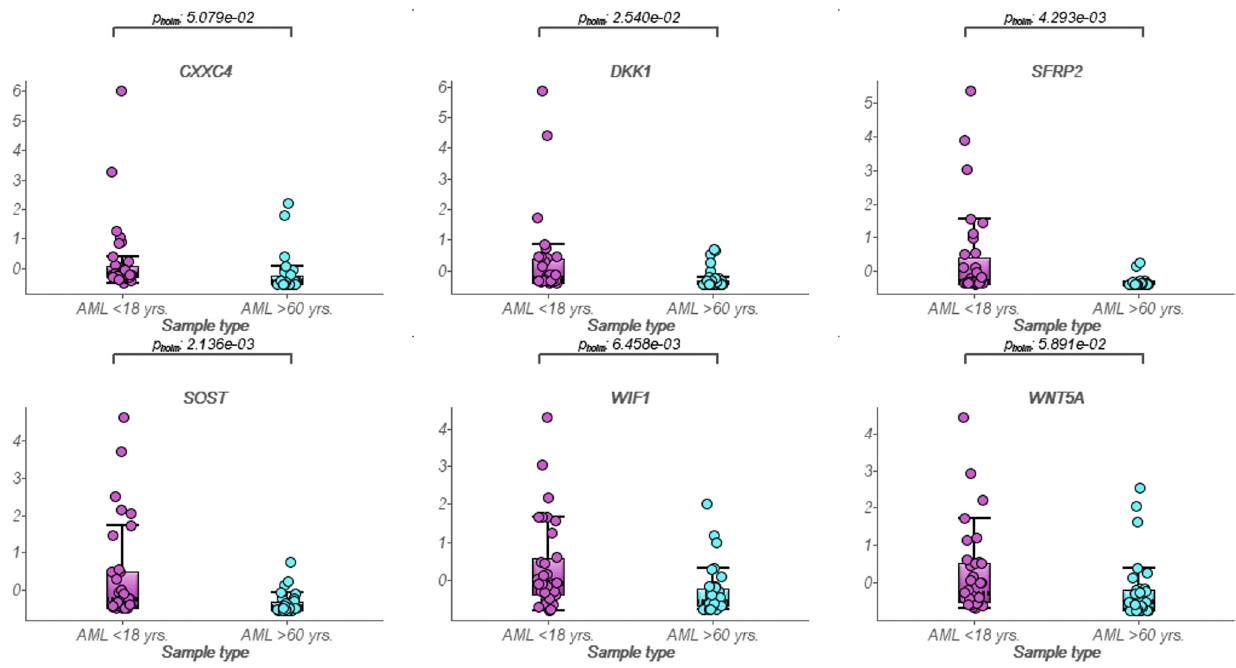
Figure 3. Box plot representing suppressed expression of selective Wnt / β‐ catenin inhibitors among elderly AML compared to pediatric AML